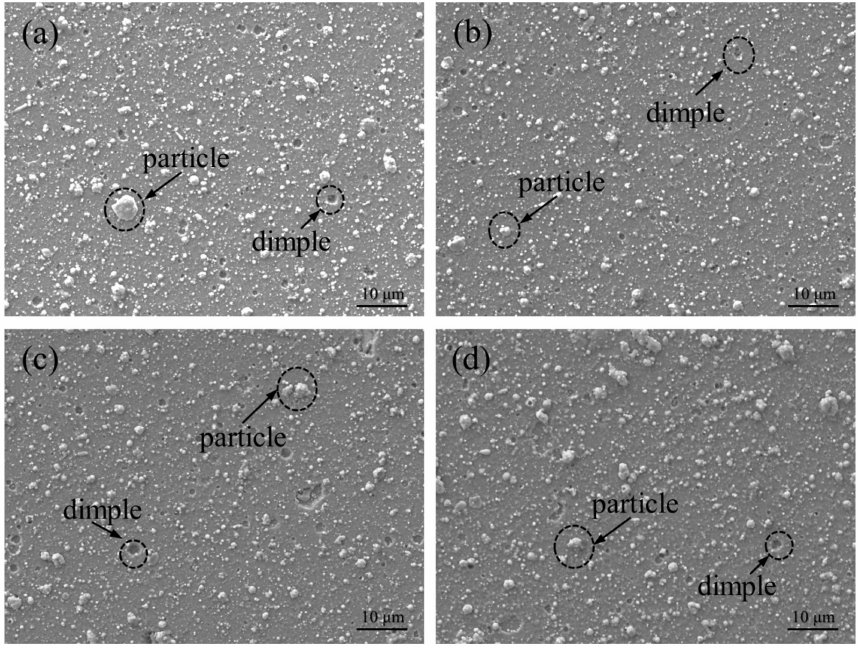
Figure 1. Surface morphology of the coating at different bias voltages: ( a ) − 60 V; ( b ) − 80 V; ( c ) − 100 V; ( d ) − 120 V.